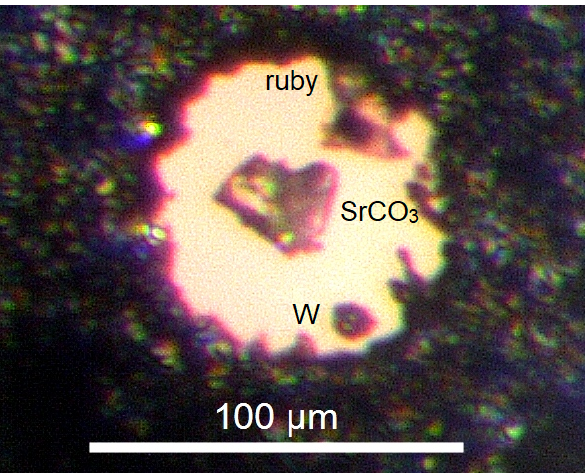
Figure 1. Diamond anvil cell at 25.9GPa loaded with a single crys- tal of SrCO 3 , with neon as a pressure-transmitting medium, a ruby sphere, and a piece of tungsten. The beam size was 2µm × 2µm FWHM. Table 1. Observed d spacings of the post-aragonite phase SrCO 3 -II at 26.3GPa and room temperature in comparison with those from previous work (Ono et al.,